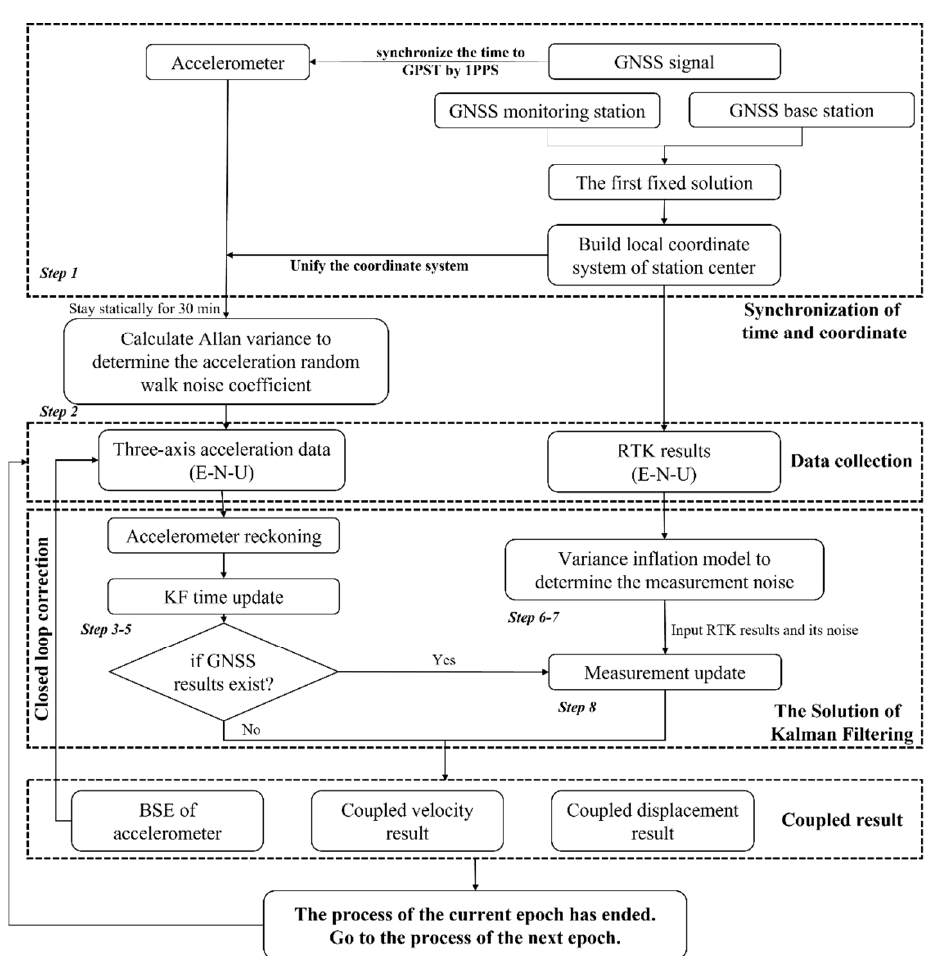
Figure 2. The flowchart of the adaptively coupled GNSS/accelerometer monitoring algorithm.